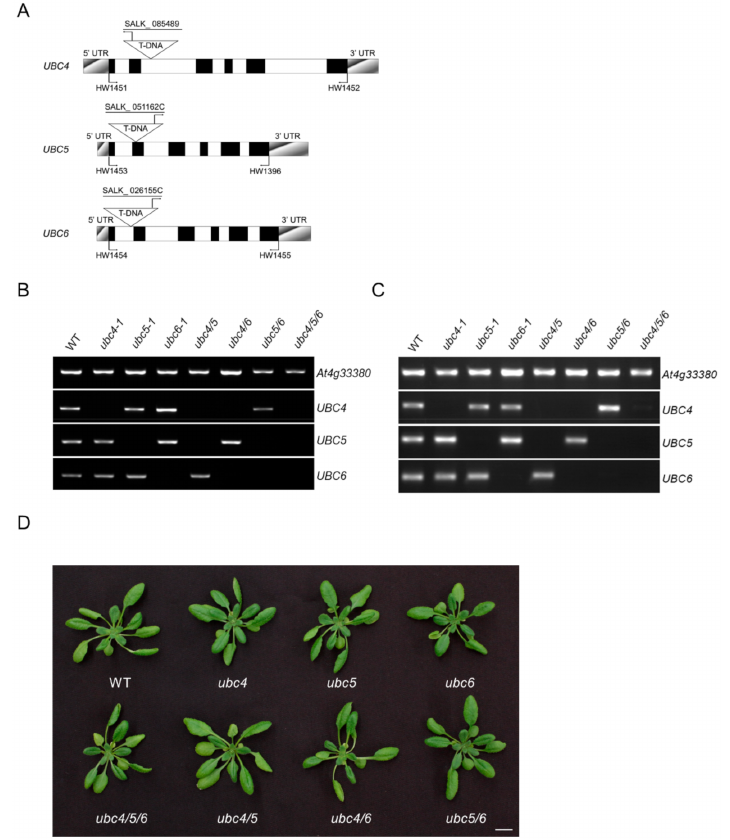
Figure 1. Characterization of ubc4, ubc5, and ubc6 mutants. ( A ) Schematic representation of the genomic structures of UBC4 , UBC5 , and UBC6 with the locations of primers and insertion sites of T-DNA in ubc4-1 , ubc5-1 , and ubc6-1 mutants. Primers 1451/1452, 1453/1396, and 1454/1455 are the gene specific primers for UBC4 , UBC5 , and UBC6 , respectively. Closed boxes, exons; open boxes, introns; shadowed boxes, untranslated regions. ( B ) Analysis of ubc4-1 , ubc5-1 , ubc6-1 , ubc4/5 , ubc4/6, ubc5/6 , and ubc4/5/6 mutant lines by genomic PCR. Gene-specific primers were used and PCR products were run in 1% agarose gels. The mutant lines used are indicated above the panels and specific genes analyzed are indicated at the right of the panels. The gene At4g33380 was used as a control. ( C ) Analysis of ubc4-1 , ubc5-1 , ubc6-1, ubc4/5 , ubc4/6 , ubc5/6 , and ubc4/5/6 mutant lines by RT-PCR. cDNAs were prepared from total RNA samples and gene-specific primers were used for amplifying the cDNA of the perspective WT gene. The transcript level of At4g33380 , as shown in the upper panel, was used as a reference. ( D ) Representative images showing plants of ubc4-1 , ubc5-1 , ubc6-1 , ubc4/5 , ubc4/6 , ubc5/6 , and ubc4/5/6 mutants. Pictures were taken at the 30-day stage. Scale bar = 1